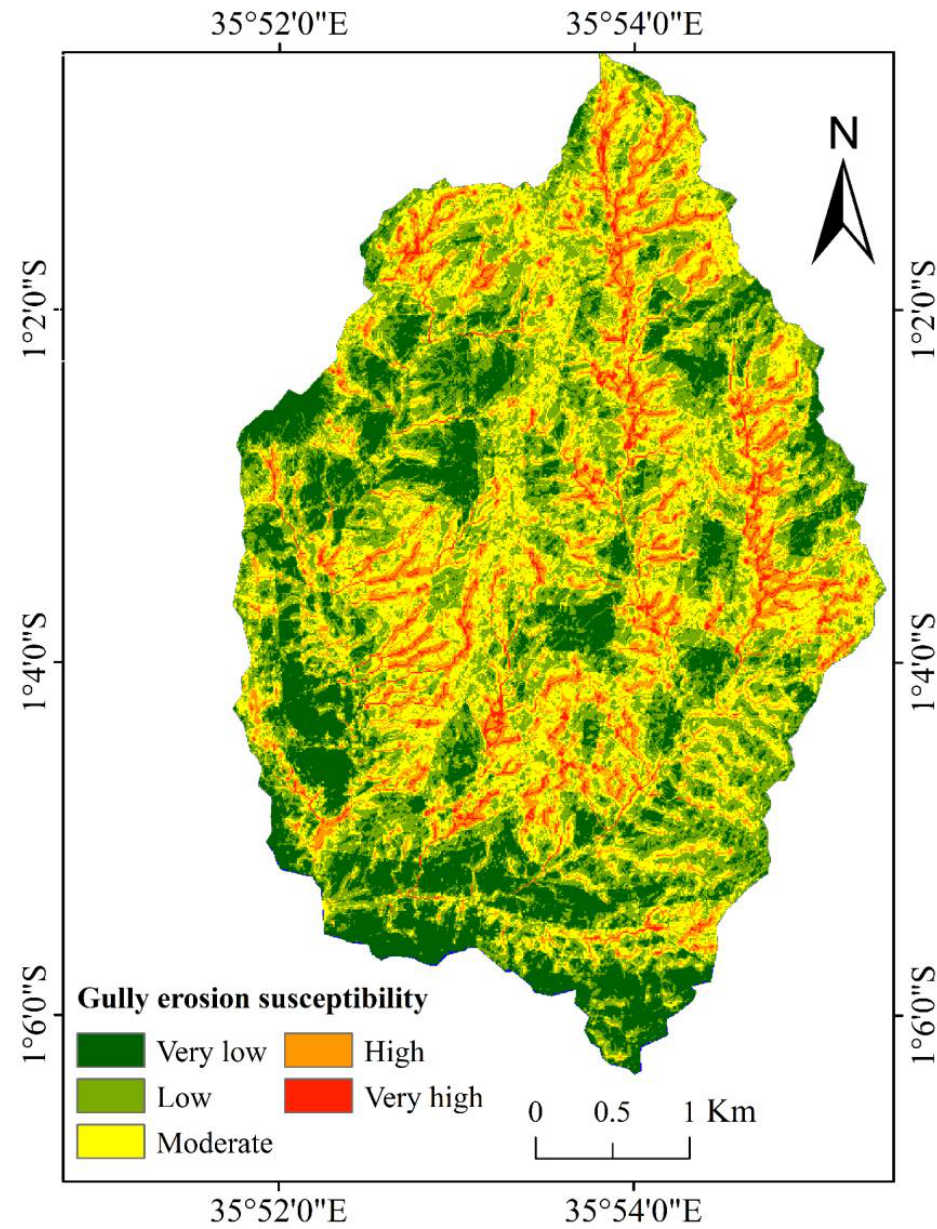
Figure 9. Map of gully erosion susceptibility of Kakia-Esamburmbur catchment using WoE–LR.